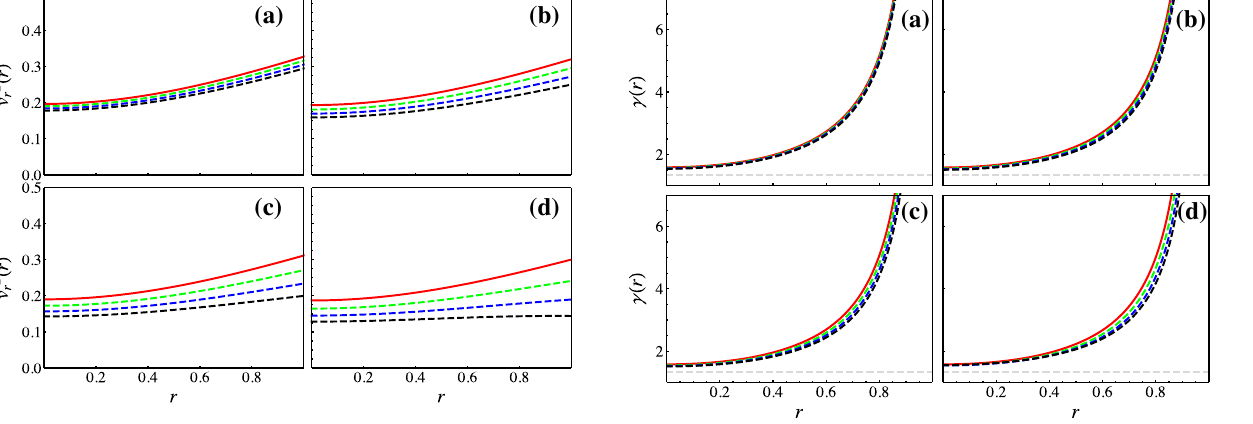
Fig. 9 Adiabatic index γ for M = 0 . 2, R = 1, c 1 = 0 . 5 and a C = − 0 . 1, b C = − 0 . 2, c C = − 0 . 3, d C = − 0 . 4. α = 0 . 1 (red line), α = 0 . 3, (green line), α = 0 . 5 (blue line), α = 0 . 7 (black